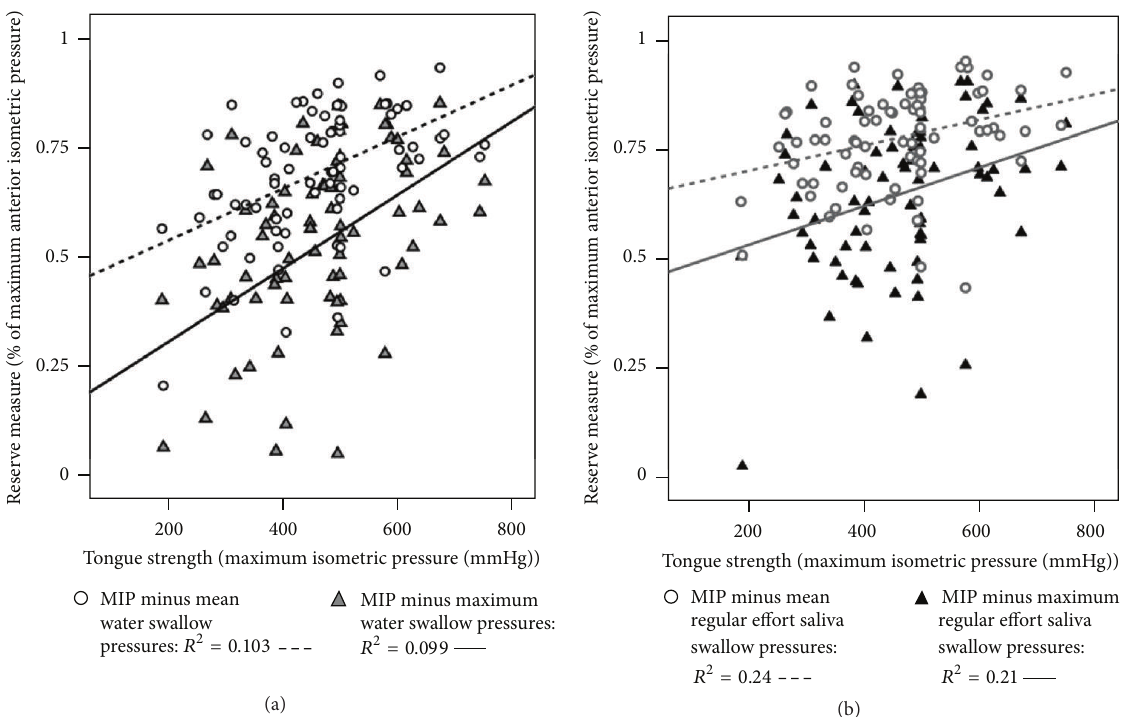
Figure 4: (a) Scatter plot showing the relationship between functional reserve measures comparing maximum isometric pressure (MIP) to water swallowing pressures and tongue strength, as measured by MIP, with swallow pressures expressed as a percentage of MIP. (b) Scatter plot showing the relationship between functional reserve measures comparing maximum isometric pressure (MIP) to regular effort saliva swallowing pressures and tongue strength, as measured by MIP, with swallow pressures expressed as a percentage of MIP.